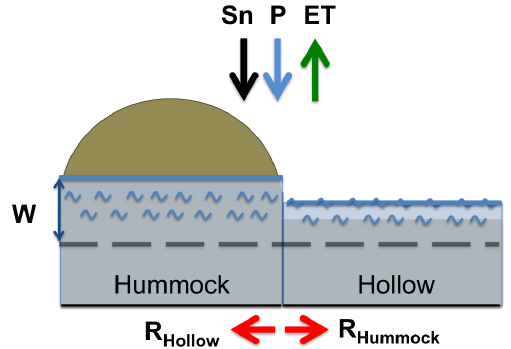
Figure 1. Schematics of the HH model showing two grid cells: a hummock and a hollow. The model represents a 1km × 1km peat- land, and works at a 1m × 1m grid cell. It is therefore able to re- solve the micro-topographical features such as hummocks and hol- lows. The figure shows two typical grid cells, a hummock and a hol- low, and the variables needed for the water table dynamics (Eq. 1 in the text). Each grid cell has an elevation which is randomly assigned from the distribution of elevation data collected in situ. For each grid cell we simulate a dynamical water table, which changes with snowmelt (Sn), precipitation ( P ), evapotranspiration (ET), and lat- eral runoff among the different grid cells ( R hummock/hollow ). These quantities regulate the change in water table depth ( W